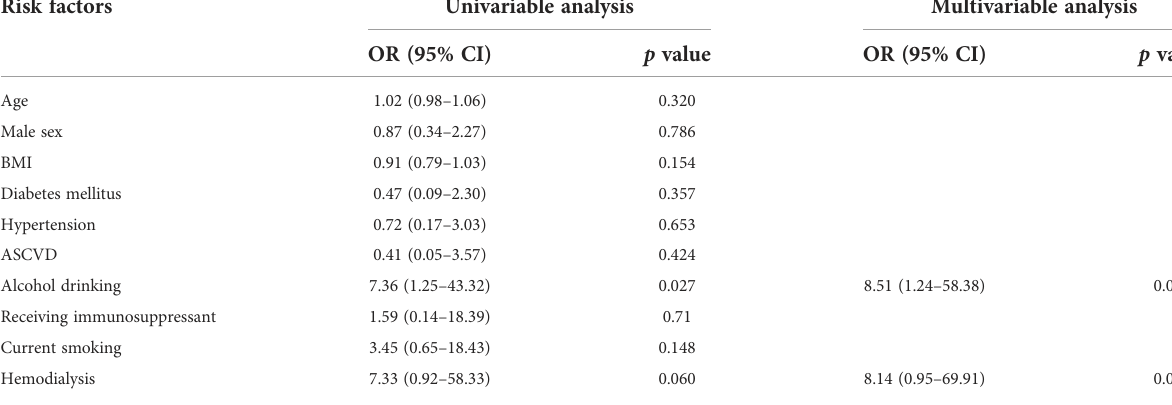
TABLE 3 Risk factors for LTBI among patients with ESKD by logistic regression analysis. Risk